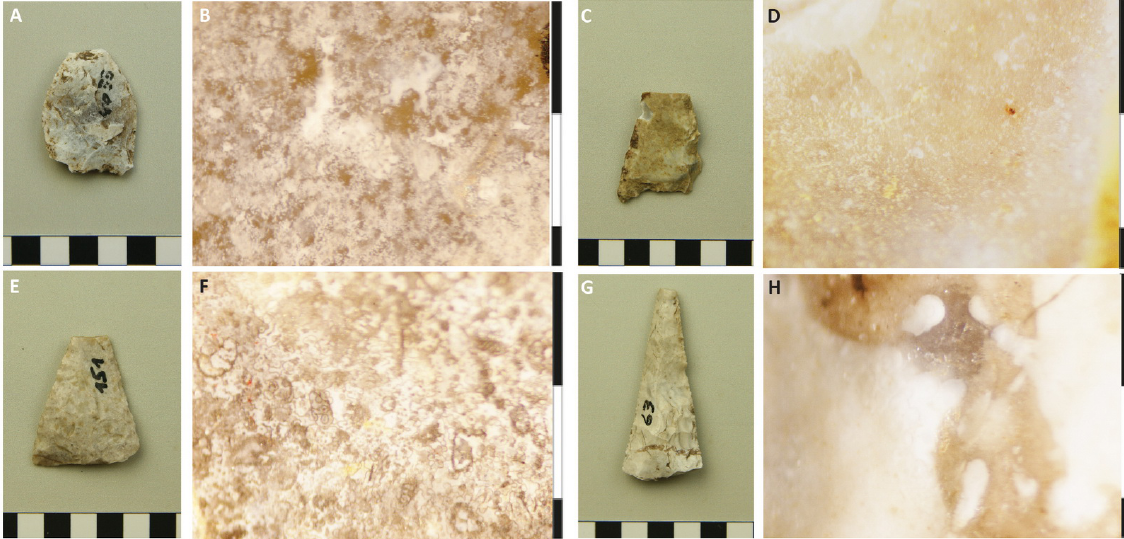
Figura 11. Microfácies 8: A e B; Microfácies 9: E e F; Microfácies 10: C, D, G e H. Figure 11. Microfacies 8: A and B; Microfacies 9: E and F; Microfacies 10: C, D, G and